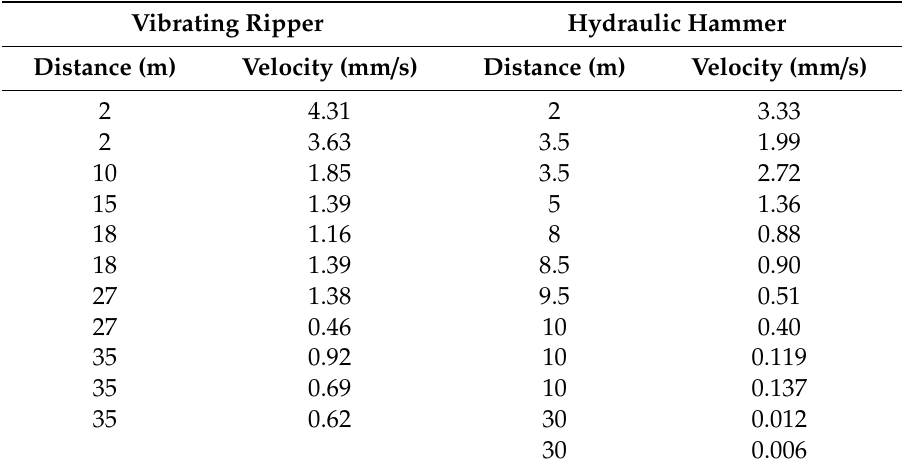
Table 3. Velocities at di ff erent distances for the excavation / fragmentation equipment.